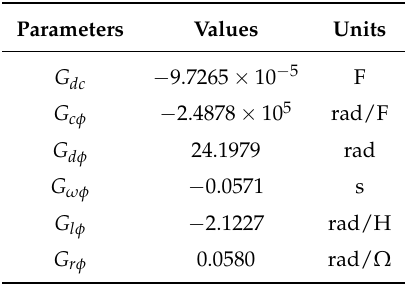
Table 2. Gain functions of the linearized control